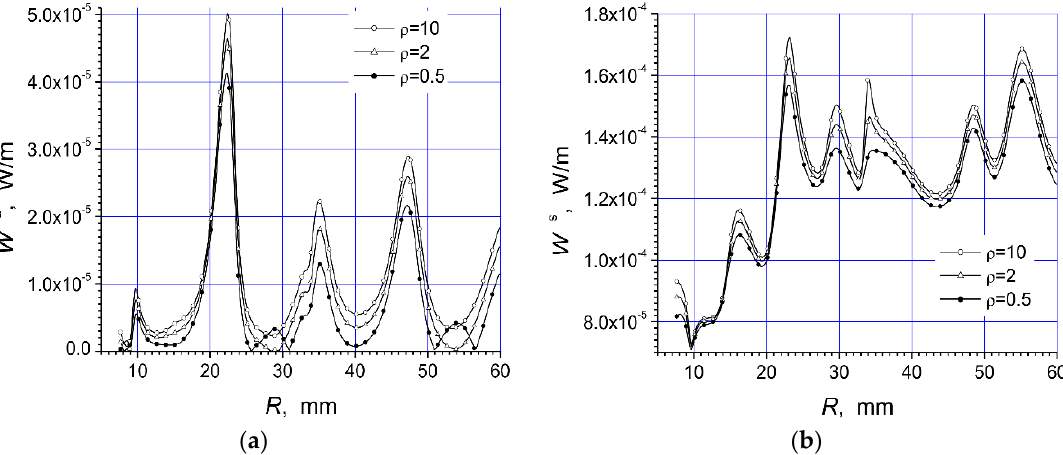
Figure 5. Dependencies of absorbed power ( a ) and scattered power ( b ), of the array Figure 1b, on the arc radius R at the parallel polarized incident wave with f = 12 GHz.